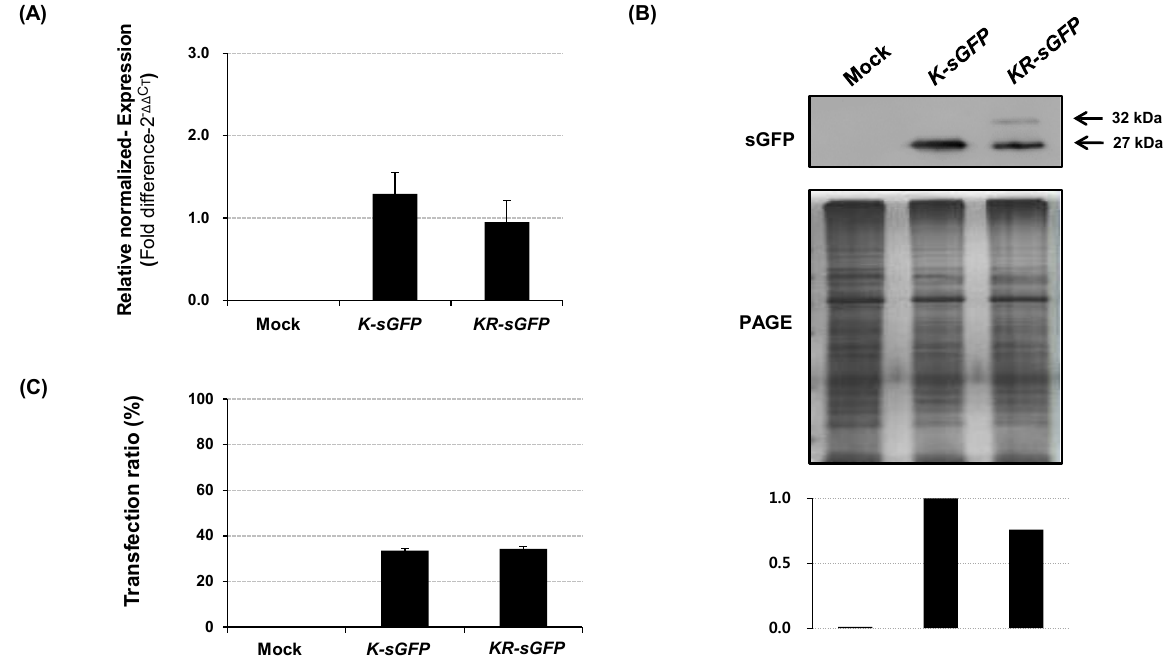
Figure 4. Comparison of K-sGFP and KR-sGFP constructs based on non-FCA analysis. ( A ) The mRNA transcripts of sGFP and rRTp-sGFP were compared using real-time PCR. The rice ubiquitin gene was used as an internal reference for quantitative normalization; ( B ) The expression efficiency of proteins compared by western blot analysis. Polyclonal rabbit antibody against sGFP was used at a titer of 1:5000 and the image of PAGE gel was used to show relative quantities of the loaded proteins. The graph shows the relative band intensities quantified using LAS4000 software and ( C ) The ratio of protoplast cells expressing sGFP proteins was analyzed by hemocytometer measurements. A volume of 10 μL of the transformed protoplasts was mounted on a hemocytometer and the images were obtained using the DIC and FITC-A channels of a confocal microscope (200× magnification). The sGFP-expressing cells were identified as the green fluorescent signals. The error bars show the SEM of data acquired from three independent transfections. Control samples were prepared by PEG transfection with no plasmid